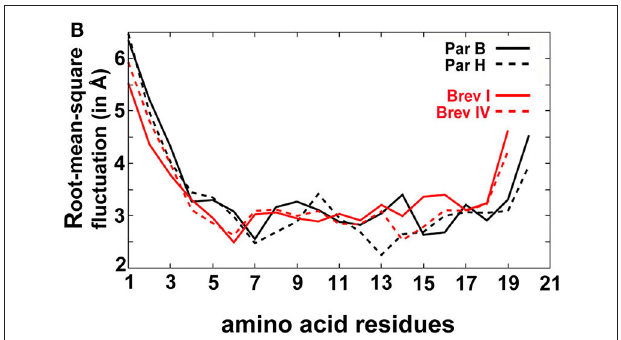
FIGURE 4 | (B) The root-mean-square deviation (in Å) calculated for each residue for all sequences gives an idea of the average fluctuation undergone by the